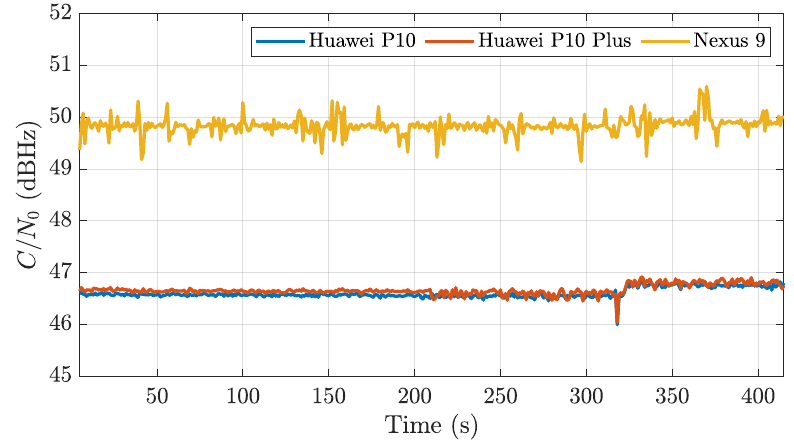
Figure 9. C / N 0 comparison between Android devices in a controlled